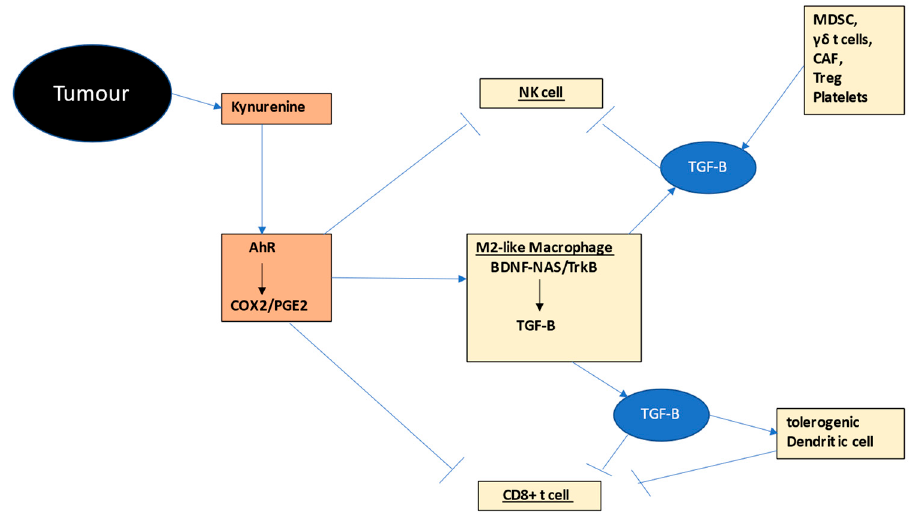
Figure 2. Shows how tumor-(black shade) derived kynurenine activation of the AhR drives COX2/PGE2 (bronze shade) in M2-like macrophages, NK cells and CD8+ t cells (other tumor microenvironment cells in gold shade). PGE2 in macrophages induces TrkB activation by BDNF and likely by NAS, thereby increasing TGF-B (blue shade), which then induces ‘exhaustion’ in NK cells and CD8+ t cells, as well as a tolerogenic dendritic cell, the latter further suppressing CD8+ cell activation. Numerous other tumor environment cells, including MDSCs, γδ t cells, CAF, Treg and platelets also release TGF-B. The AhR therefore interacts with other tumor fluxes, such as glutamate and ATP (Figure 1), to change the NF-kB and YY1 activation by increasing the NAS/melatonin ratio, with consequences including TGF-B release from macrophages, reinforcing NK cell and CD8+ t cell ‘exhaustion’. The NAS/melatonin ratio may therefore be an important determinant of classical pro- cesses underpinning ‘immune-checkpoint’ induction. Abbreviations: AhR: aryl hydrocarbon receptor; BDNF: brain-derived neurotrophic factor; CAF: cancer-associated fibroblasts; COX: cyclooxygenase; CYP: cytochrome P450; MDSC: myeloid-derived suppressor cell; NAS: N-acetylserotonin; NF-kB: nuclear factor kappa-light-chain-enhancer of activated B cells; NK: natural killer; PGE2: prostaglandin E2; TGF: transforming growth factor; Treg: regulator t cell; TrkB: tyrosine receptor kinase B; YY1: yin yang 1.